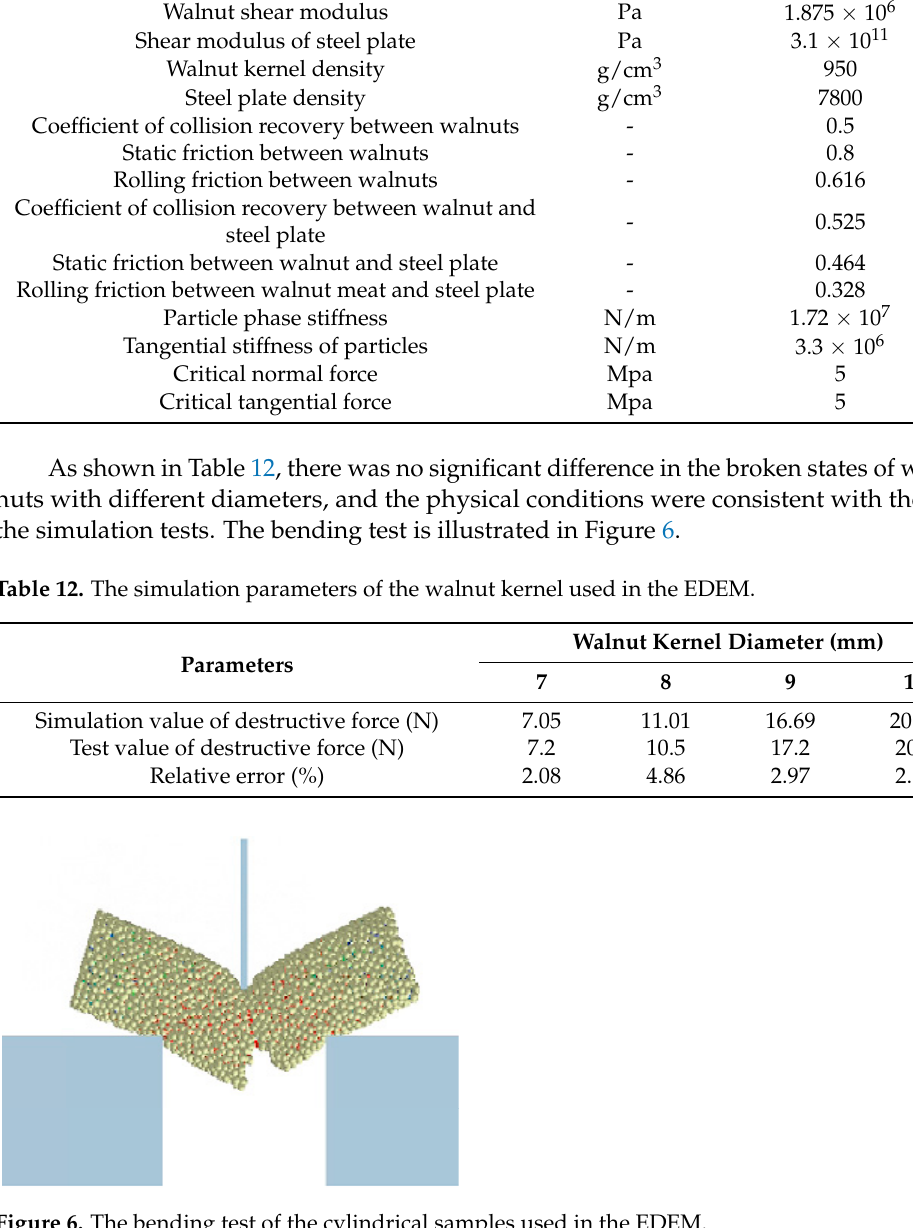
Table 11. The parameters of cylindrical sample used in EDEM.